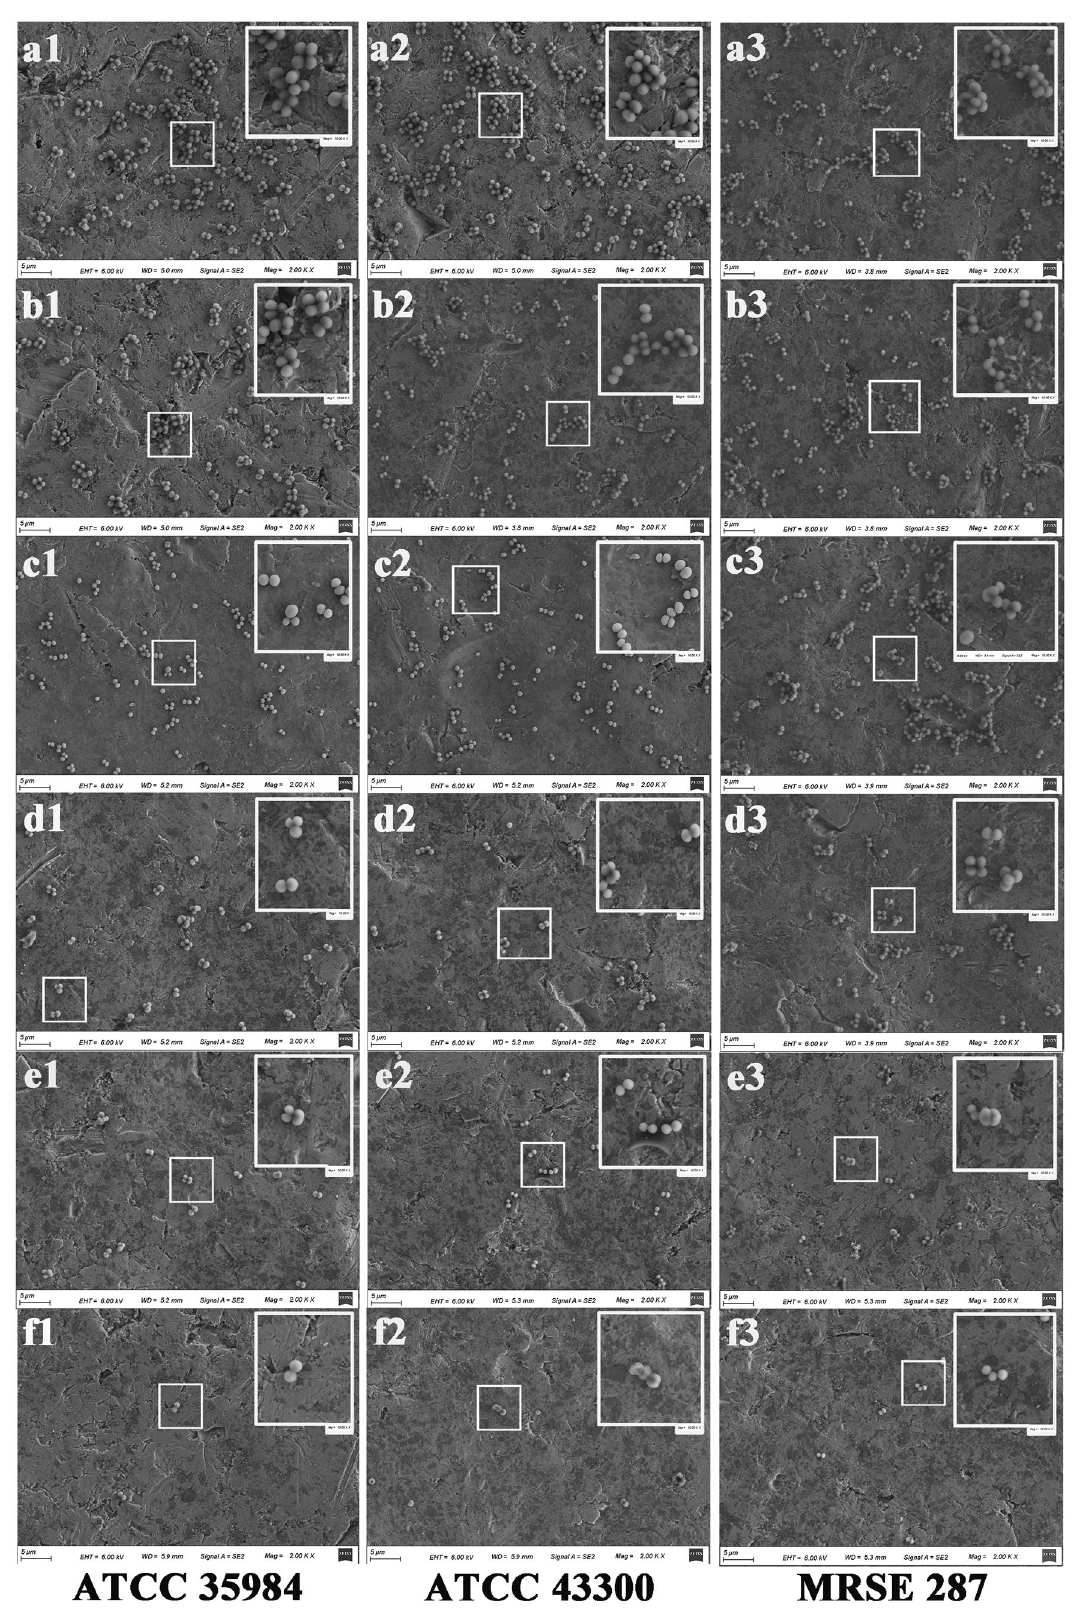
Figure 2. SEM of bacterial adhesion on the titanium surface. Compared with control, 1/8MIC SH and 1/4MIC SH groups, 1/2MIC, 1MIC SH and Vancomycin can obviously inhibit bacterial adhesion. ( a ) Control group. ( b ) 1/8MIC SH group ( c ) 1/4MIC SH group. ( d ) 1/2MIC SH group. ( e ) 1MIC SH group. ( f ) Vancomycin group. The insert photograph is a 5× magnification of the white box in the image. Magnification, ×2000. Scale bars, 5